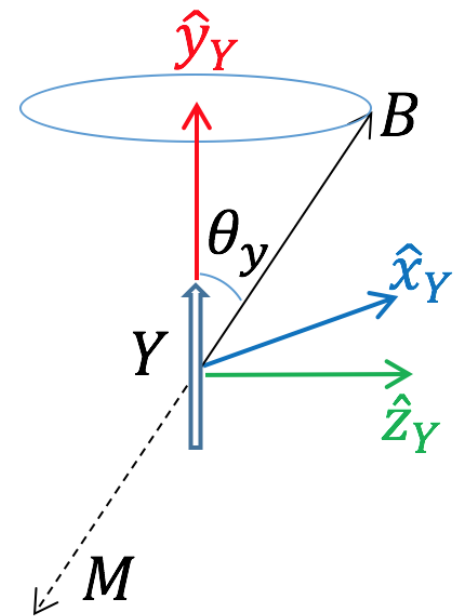
Figure 1. The Y → BM decay, with the spin direction of Y along the y